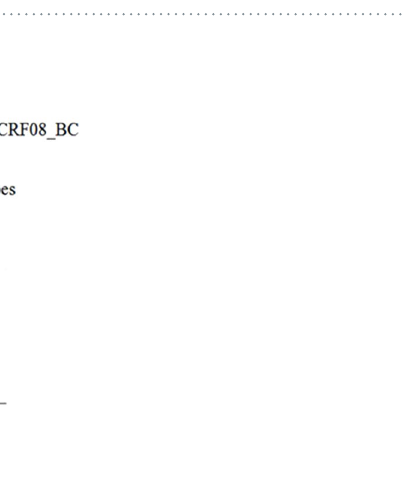
Table 1. Demographic characteristics of 114 HIV-1 participants classified by viral subtypes in Wuxi.